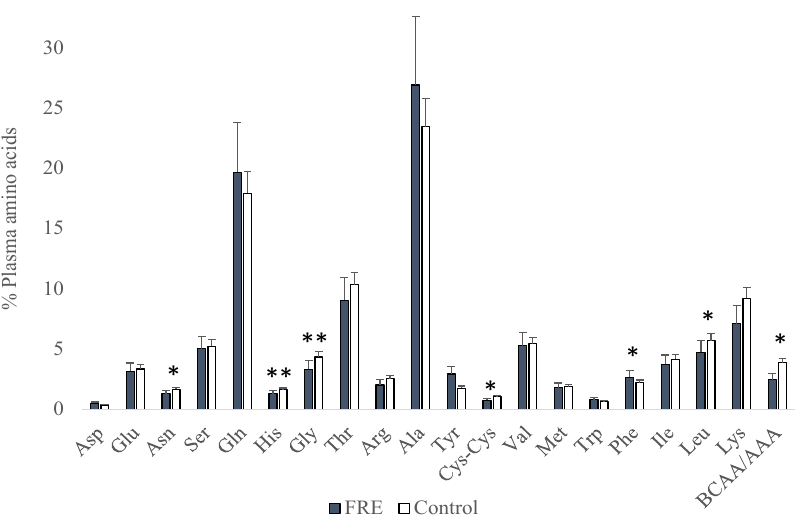
Figure 1. Amino acid proportions (%) in plasma from FRE (food-responsive enteropathy) and control dogs (* p < 0.05; ** p < 0.01).